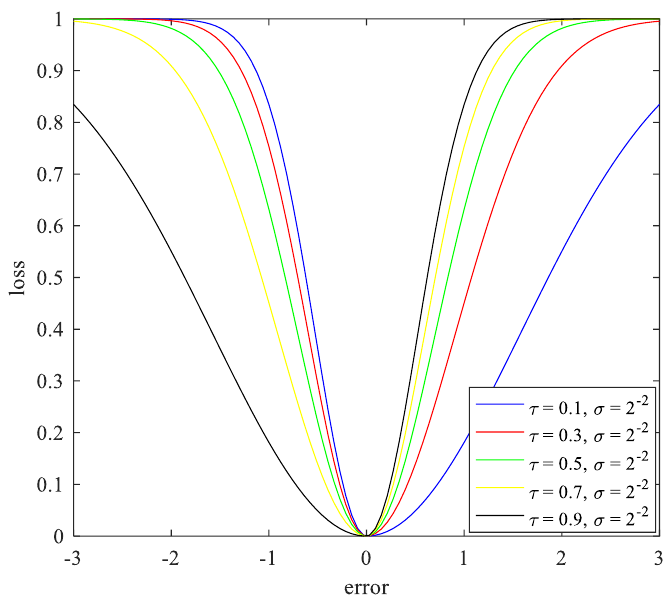
Figure 1. Asymmetric C-loss function.